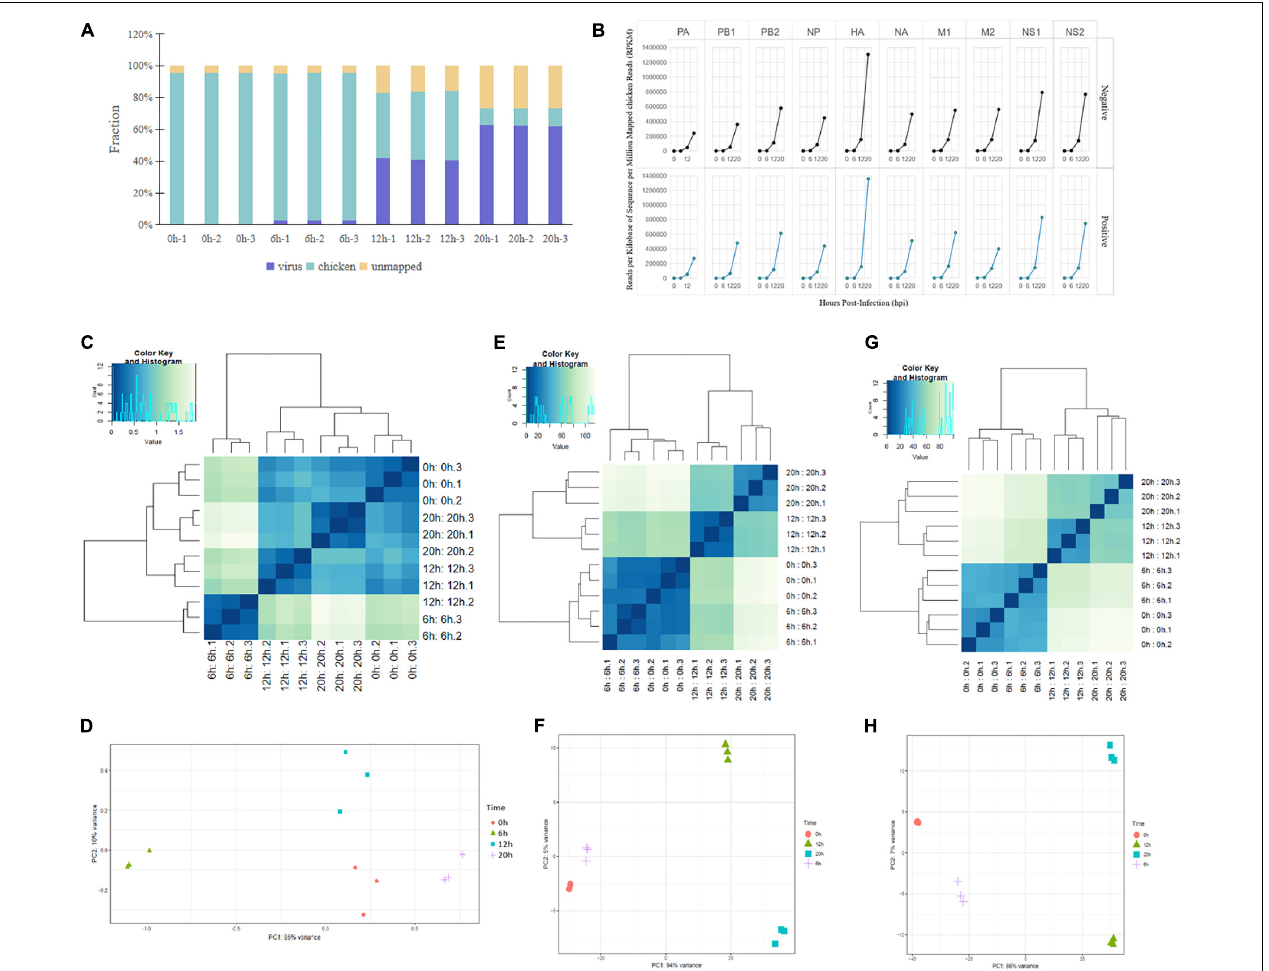
FIGURE 1 | Dual RNA-seq data of H5N1-infected chicken DF1 cells. (A) Total RNA-seq read counts were mapped by read fraction distribution. (B) Temporal expression of H5N1 influenza viral RNAs. Negative- and positive-stranded RNAs of each viral segment expressed as reads per kilobase of sequence per million mapped reads normalized to total host reads. (C,E,G) PCA of the differentially expressed influenza virus RNAs, chicken mRNAs, and chicken lncRNAs at four time points post infection. (D,F,H) Cluster analysis of the differentially expressed influenza virus RNAs, chicken mRNAs, and chicken lncRNAs at four time points post